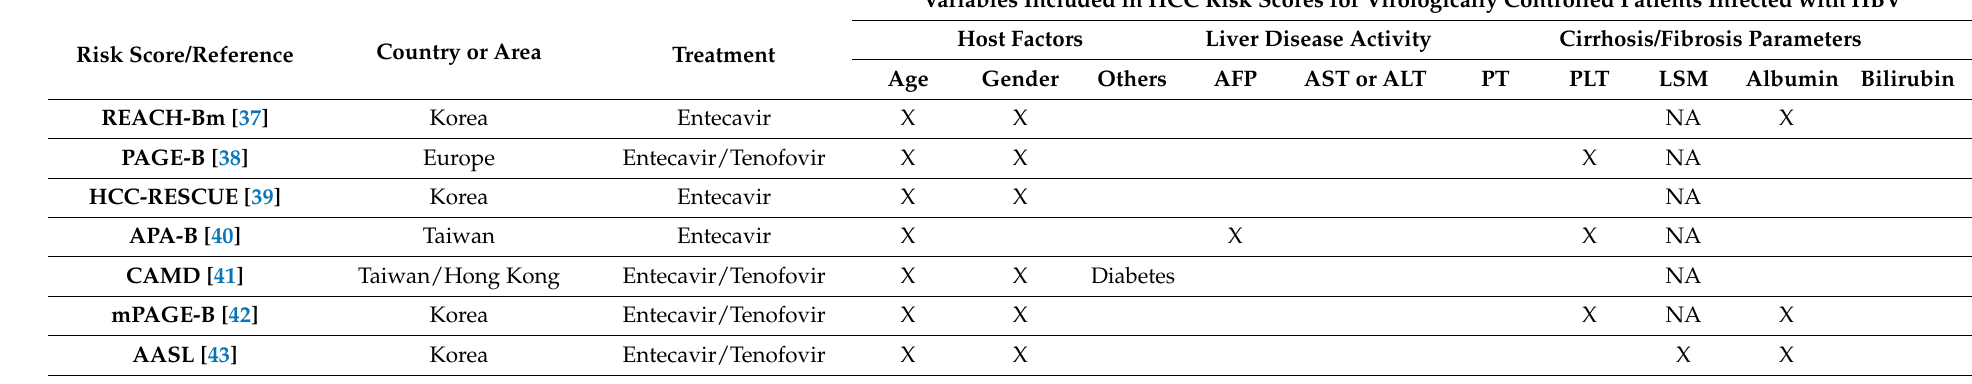
Table 1. Variables included in hepatocellular carcinoma (HCC) risk scores (or associated with HCC) developed in individuals with chronic hepatitis B and in patients infected with HCV with advanced fibrosis who achieved virological clearance or control status following antiviral therapy. Variables Included in HCC Risk Scores for Virologically Controlled Patients Infected with